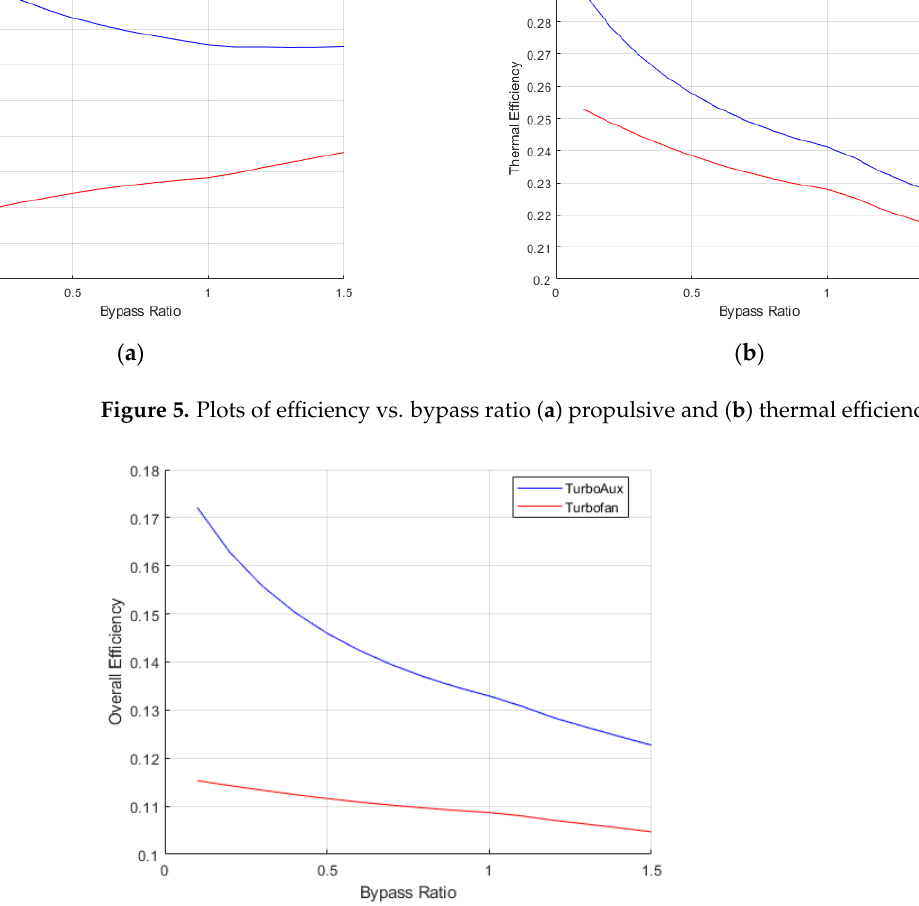
Figure 6. Plot of overall efficiency vs. bypass ratio.